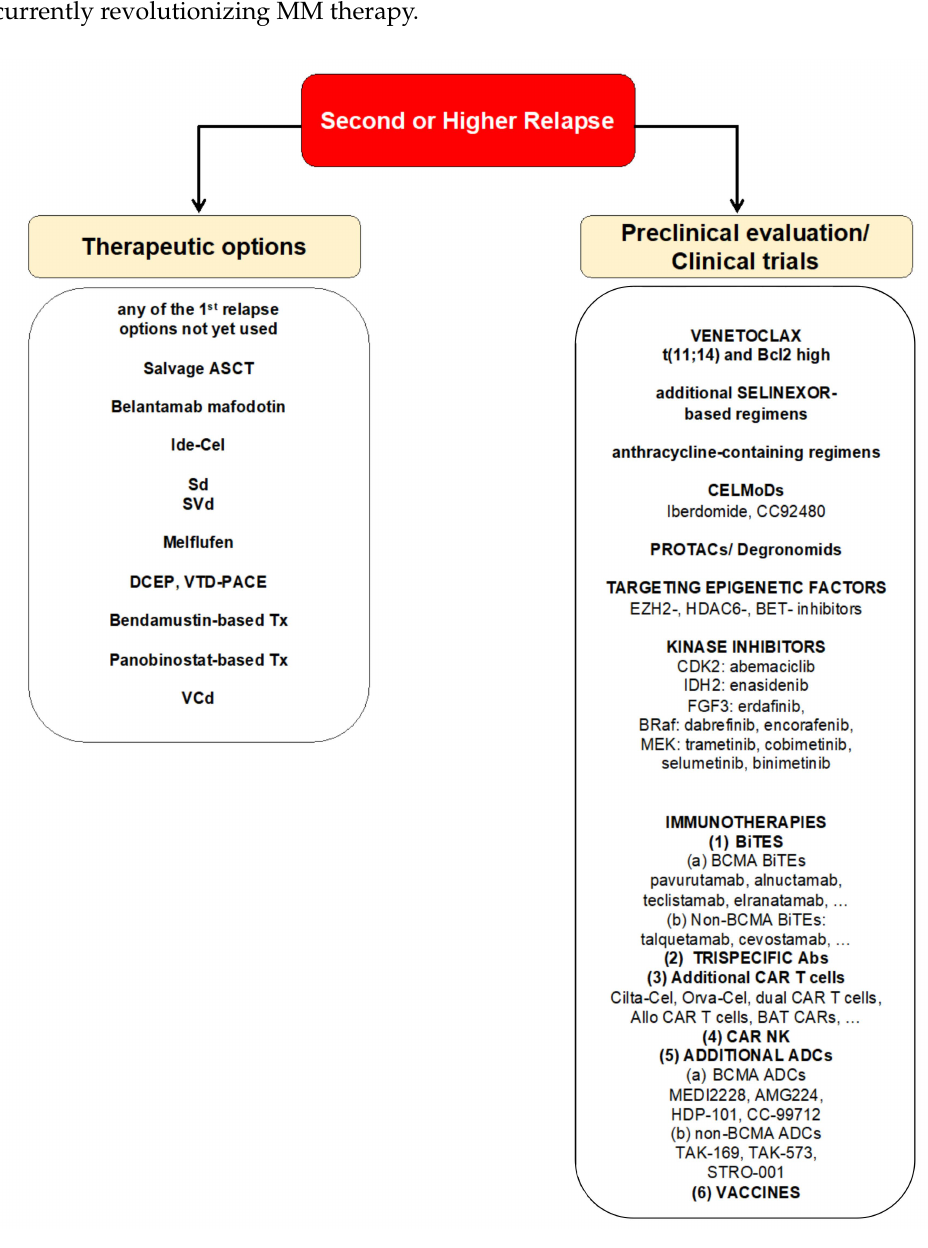
Figure 2. Treatment options for MM patients with a second or higher relapse. Listed treatment options are selected and not inclusive of all available regimens. Evidence for these treatment regimens stems from randomized-controlled trials discussed in this review article. S, Selinexor; PROTACs, proteolysis-targeting chimera; BCMA, B cell maturation antigen; DCEP, dexametha- sone/cyclophosphamide/etoposide/cisplatin; VTD-PACE, V (bortezomib), T (thalidomide), D (dex- amethasone), PACE